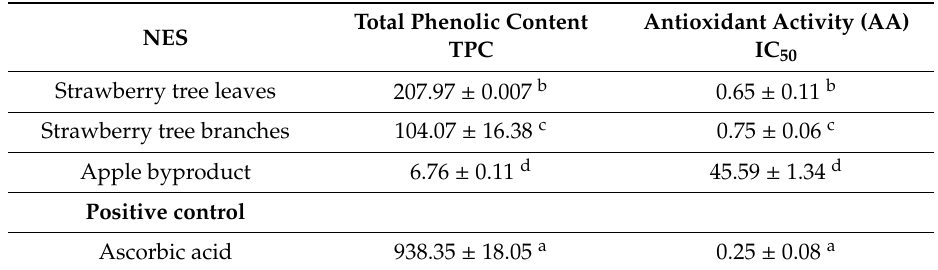
Table 2. Total phenolic content (TPC) and Antioxidant activity of natural-based extracts (NES). Ascrobic acid is the positive control.